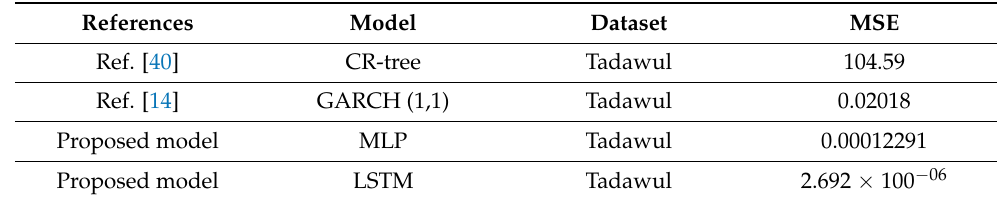
Figure 18. Regression plot of MLP for predicting stock markets in Saudi Arabia in the training phase, ( a ) communication ( b ) energy, ( c ) financial and ( d ) industrial sectors. Table 6. Results of proposed artificial intelligence model against existing system for predicting Saudi Stock Exchange